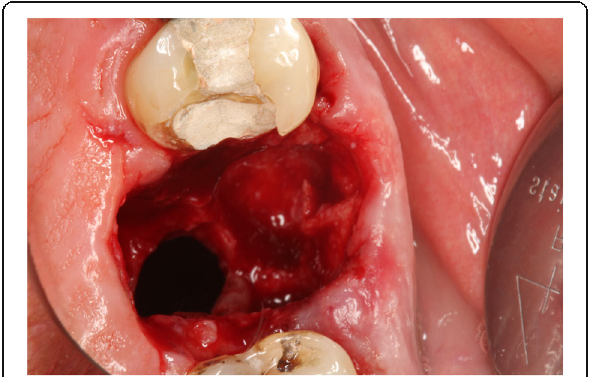
Fig. 4 Clinical OAC after the extraction of a molar